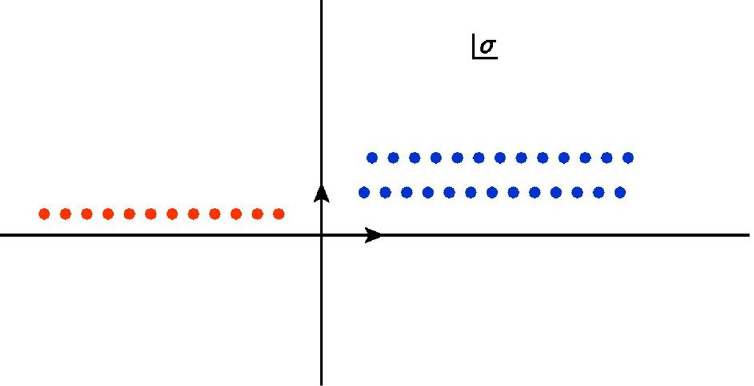
Figure 5. Mellin-Barnes type integration contour where the path of integration is parallel to imaginary vertical axis. The contour separates chains of poles which lie entirely on the right and the chains of poles that lie entirely on the